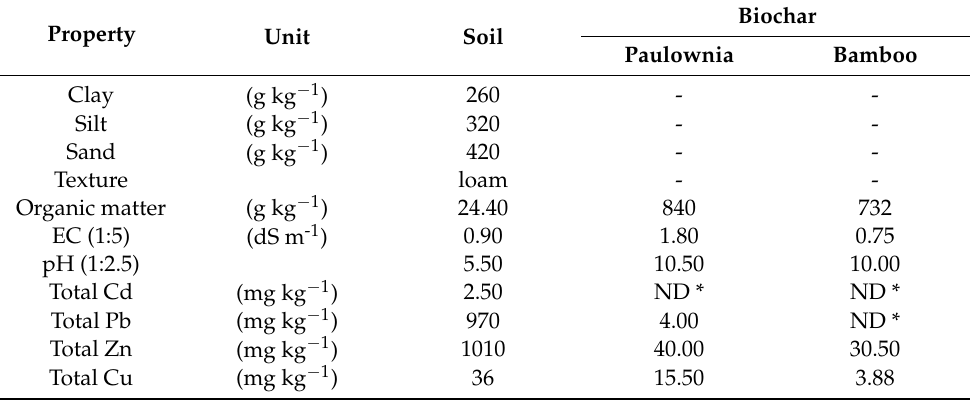
Figure 1. The energy dispersive X-ray spectra (EDS) collected from the scanning electron microscopy (SEM) regions of paulownia biochar ( a ), and bamboo biochar ( b ). Table 1. Some characteristics of the tested soil and the utilized biochar.